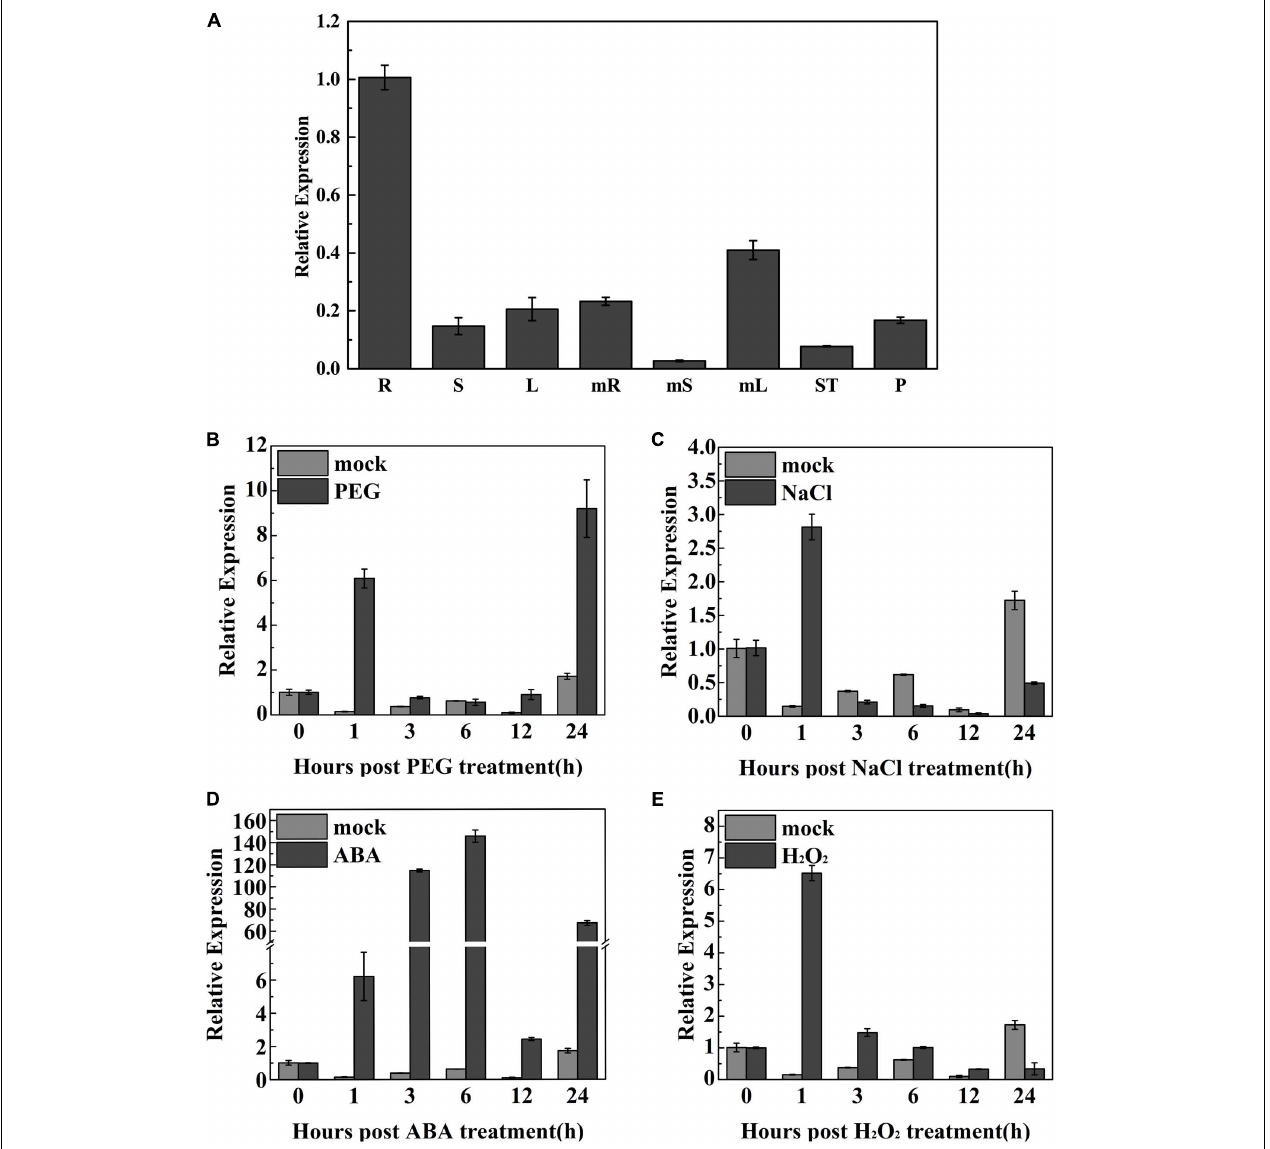
FIGURE 3 | Expression profiles of TaODORANT1 in wheat. (A) Organ-specific expression assay of TaODORANT1 in wheat (R: seedlings root; S: seedlings stem; L: seedlings leaf; mR: mature root; mS: mature stem; mL: mature leaf; ST: stamen; P: pistil). (B–E) Expression patterns of TaODORANT1 in 14-day-old wheat seedlings after treatment with 20% PEG6000, 200 mM NaCl, 100 µ M ABA, and 10 mM H 2 O 2 , respectively. Three independent biological replicates were performed and produced similar results. Vertical bars refer to ± SE ( n =